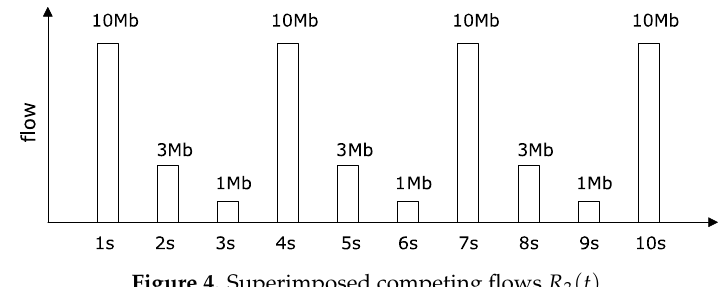
Figure 4. Superimposed competing flows R 3 ( t ) .